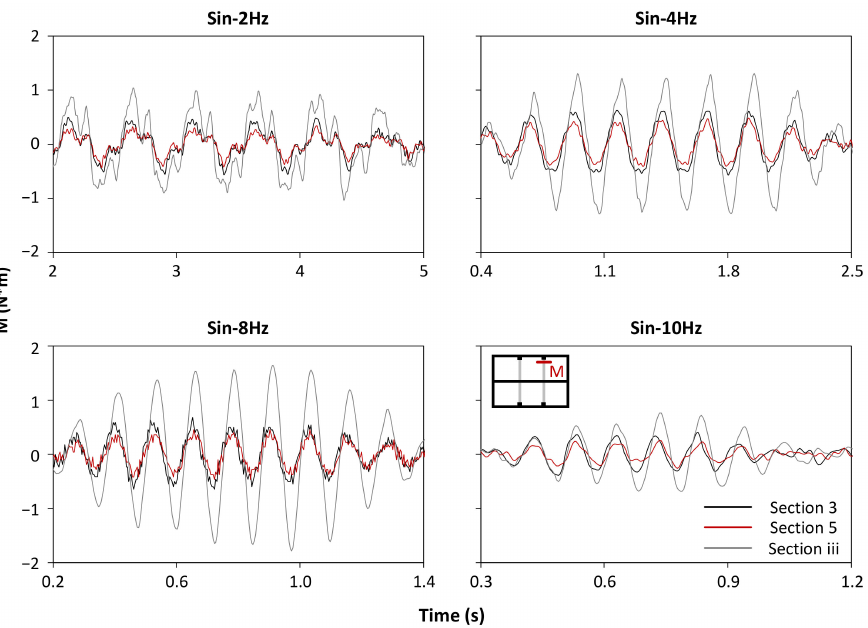
Figure 15. Time history of the bending moment at the top end of the column of the upper story, derived from the strain pair records: a comparison between the single station and different sections of interchange station in the case of four sine sweep